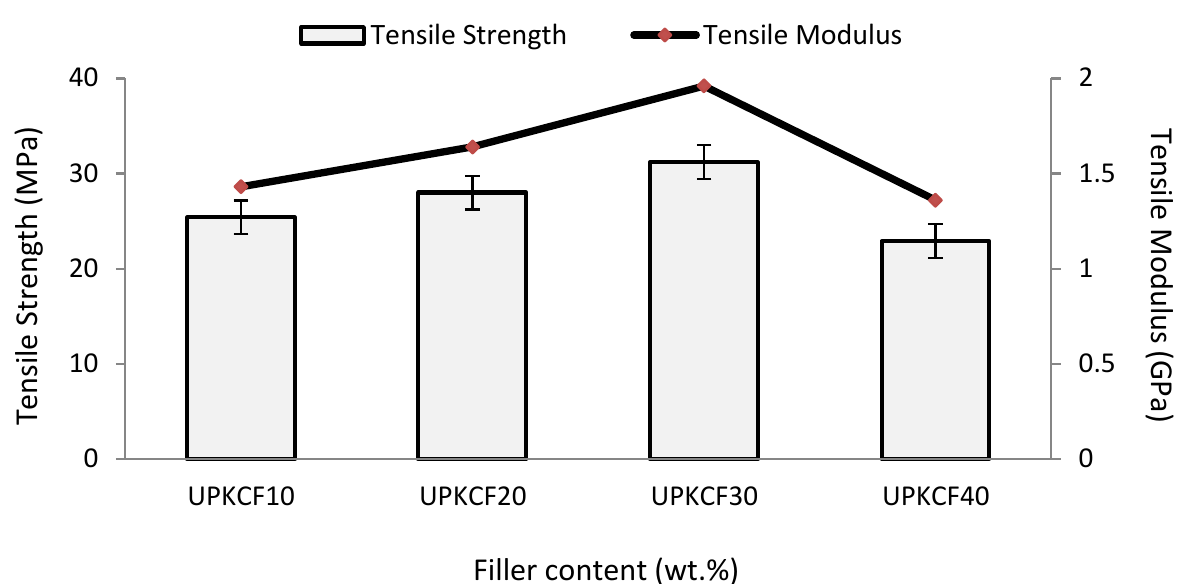
Figure 4. Tensile strength and tensile modulus of UPKCF/ER composites.